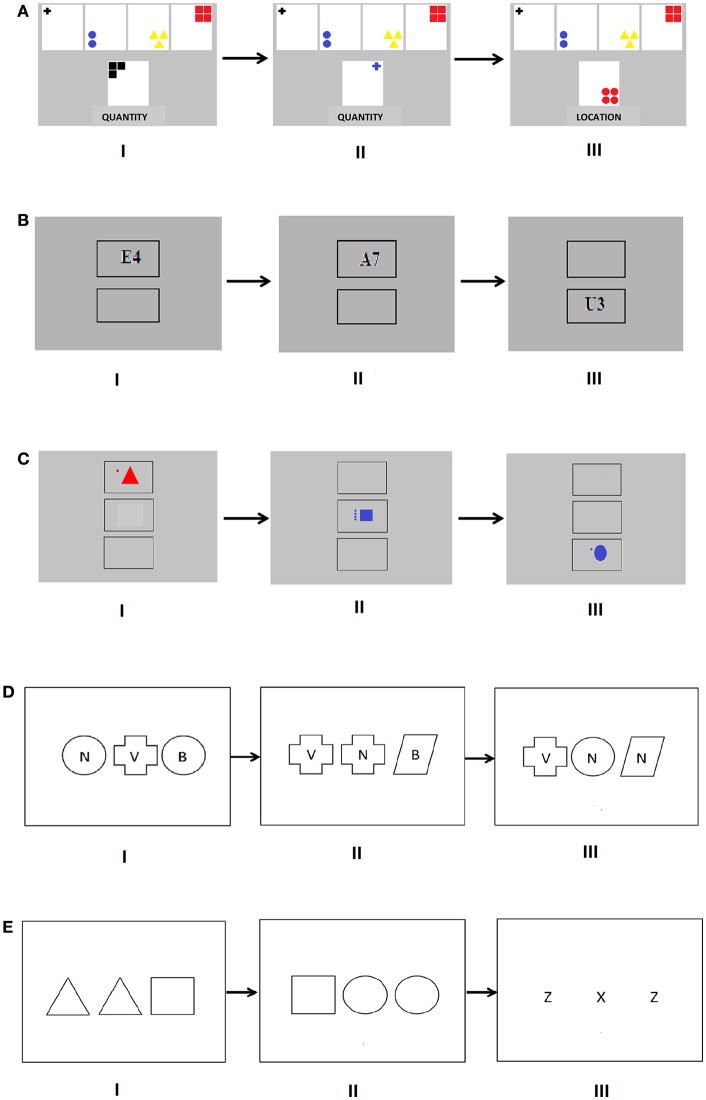
(A)
The Categorization Task. The more difficult version of the task (level 3 and 4). The stimulus cards are at the top of the screen and the response cards appear at the bottom half of the screen, and the written cue is given underneath the response card at each trial. In (I) the given sorting rule is “quantity,” that is, the participant should press “3.” In the repetition trial (II), the participant should press “1,” and in the switching trial (III) the participant is given a new cue “location” and should press “3.” (B)
The Number-Letter task. The easier version of the task (level 1 and 2). Two squares are placed vertically on the screen and the number-letter pair is presented in either one of them. In (I) the participant's task is to decide whether the number is “even” (correct response) or “odd.” In the repetition trial (II) the correct response is “odd,” and in the shifting trial (III) the participant is to decide whether the letter is a “vowel” or a “consonant.” (C)
The Dot-Figure task. The more difficult version of the task (level 3 and 4). Three squares are placed vertically on the screen and the dot-figure pair is presented in one of them. In (I) the participant's task is to decide whether the number of dots is “even” or “odd” (correct). In the switching trial (II) the participant's task is to decide whether the figure is “angular” (correct) or “round,” and in the switching trial (III) the participant is to decide whether the figure is “red” or “blue” (correct). (D)
The perceptual part of the OMO task (mixed task), where the participant responds by pressing the key that corresponds to the spatial location of the odd stimulus. In trial (I), the correct choice is the middle key that corresponds to the cross. In the repetition trial (II) the correct response is the figure to the right, that is, the parallelogram. In the switching trial (III) the correct choice is the letter “v.” (E)
The rule-based part of the OMO task (mixed task), where the participant responds by pressing a previously memorized key for that letter or figure (1 = z and triangle, 2 = x and square, and 3 = c and circle). In trial (I), the correct choice is the square. In the repetition trial (I) the correct choice is again the square. In the switching trial (III) the correct response is the letter “x.”